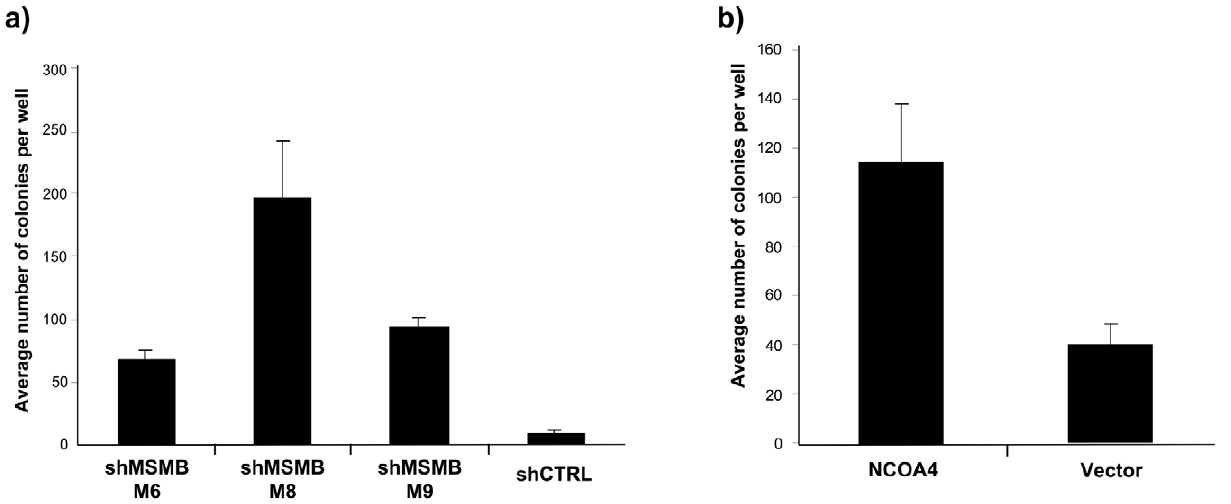
Figure 2. Suppressing MSMB or overexpressing NCOA4 is associated with increased anchorage-independent growth of prostate epithelial cells. A. Effects of suppressing MSMB with three independent shRNAs in LHSAR cells (p-values 0.0001; M6, 0.0023; M8, and 0.0001; M9). The increase in anchorage-independent growth inversely correlates with the degree of MSMB suppression (Figure S4). B. Anchorage-independent growth of LHSAR cells overexpressing NCOA4 and a control vector (p=0.0074).